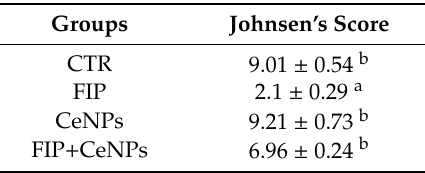
Table 6. Comparison of the Johnsen’s score among studied rat groups.